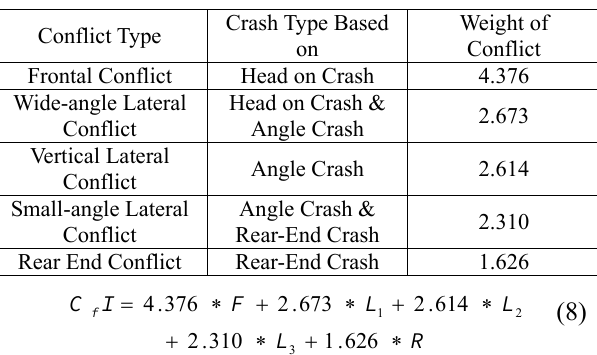
Table 3. Weights of Five Type of Conflict